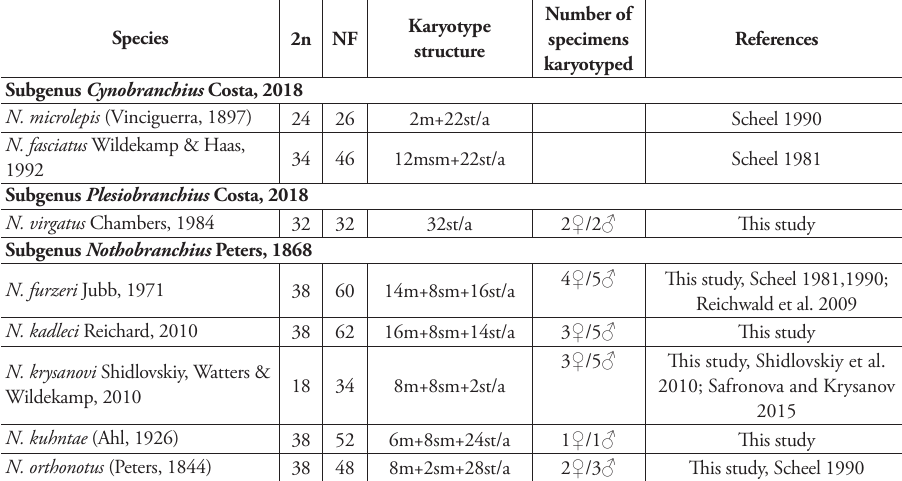
Table 1. Diploid chromosome numbers (2n), fundamental numbers (NF) and karyotype structures